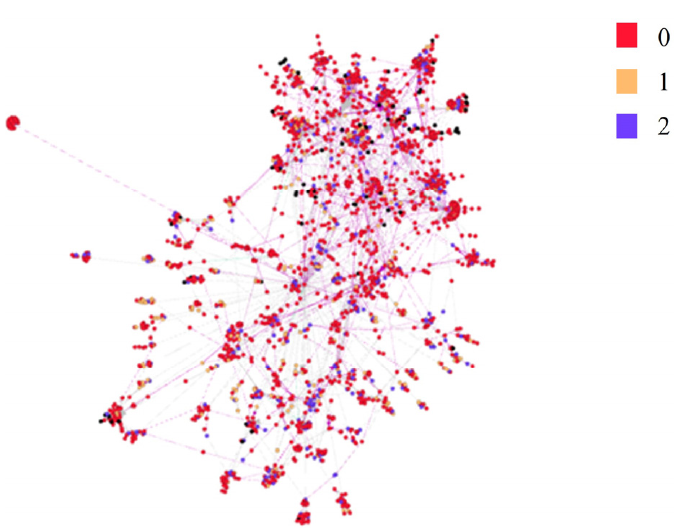
Figure 2. Distribution of users’ vaccine attitudes.